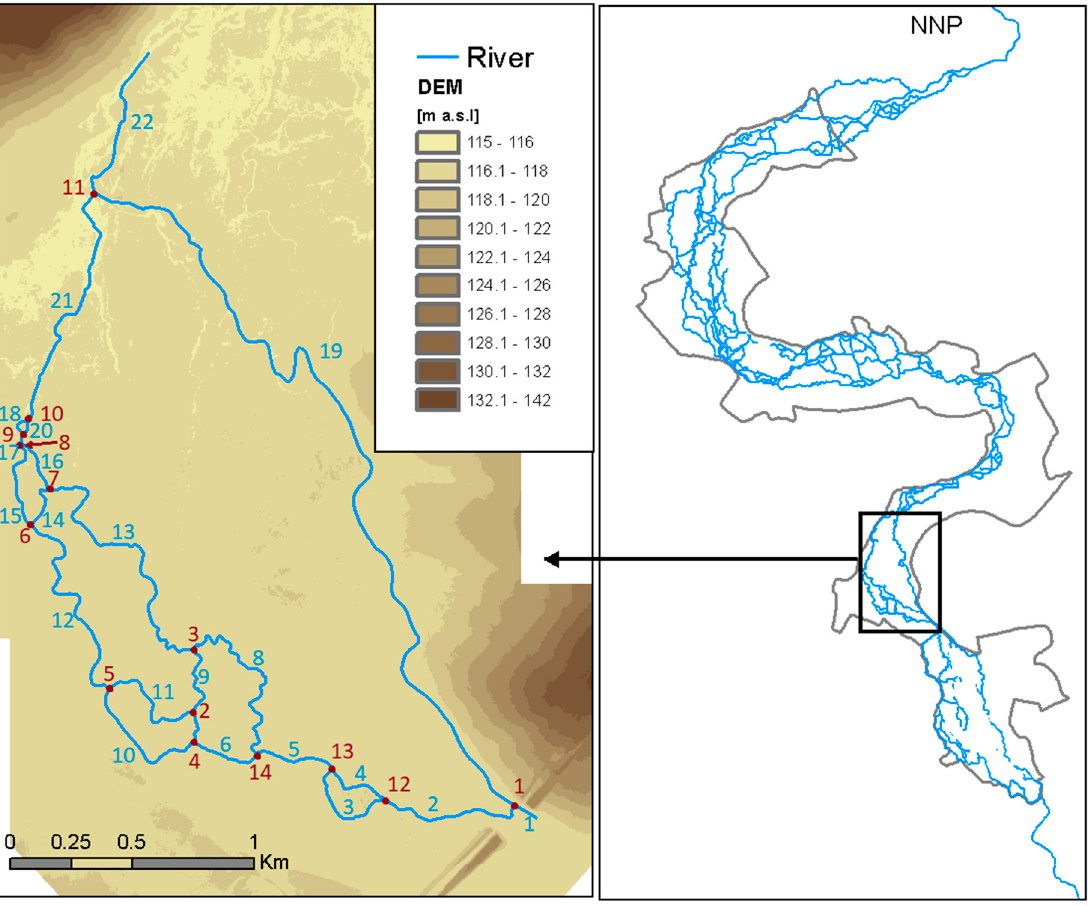
Figure 2. Reach of the anastomosing river for which model was developed. Red font describes the junction number and blue font the reach number.